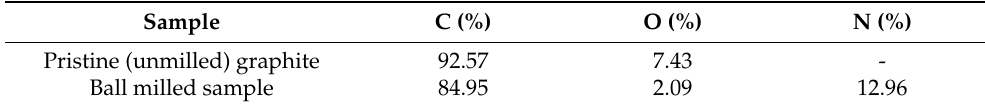
Figure 4. ( a ) Comparison of XPS survey spectra of unmilled and ball ‐ milled powders (after washing with water) ( b ) deconvolution of C1s peak of unmilled sample ( c ) deconvolution of C1s peak of the ball ‐ milled powder and ( d ) deconvolution of N1s peak of the ball ‐ milled powder. Table 1. Atomic content from XPS survey spectra.